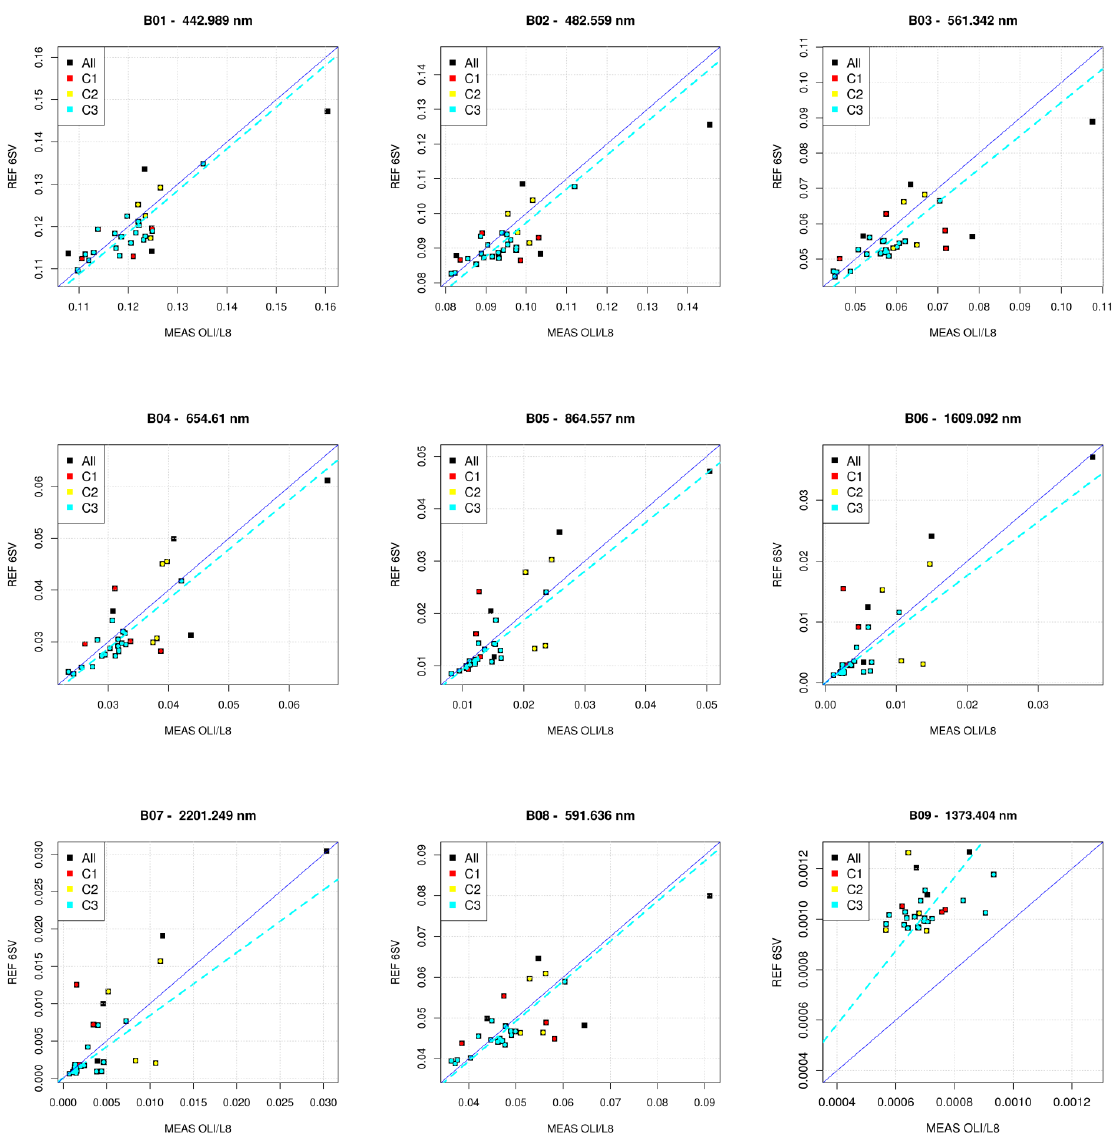
Figure 5. The TOA reflectance simulated by 6SV vs. the measured OLI/L8 TOA reflectance for each OLI/L8 band (31 total points). The red points (C1) are the data removed by the first screening, the yellow points (C2) are the data removed by the second screening, and the cyan points (C3) represent the final value used for Belharmony gains retrieval (19 points). The median and the standard deviation of the final dataset are reported in Table 3, except for the band 9, and are useful for cirrus detection, but are not used in the optimi- zation of the sensor signal. Table 3 reports the Belharmony gains as the median of the 19 ratios (MD) with its standard deviation (SD) for each OLI/L8 band (wvl is the central wavelength retrieved by applying the Equation (2)). The SD increases with the wave- length as expected for the very low radiance in this spectral domain where the errors could